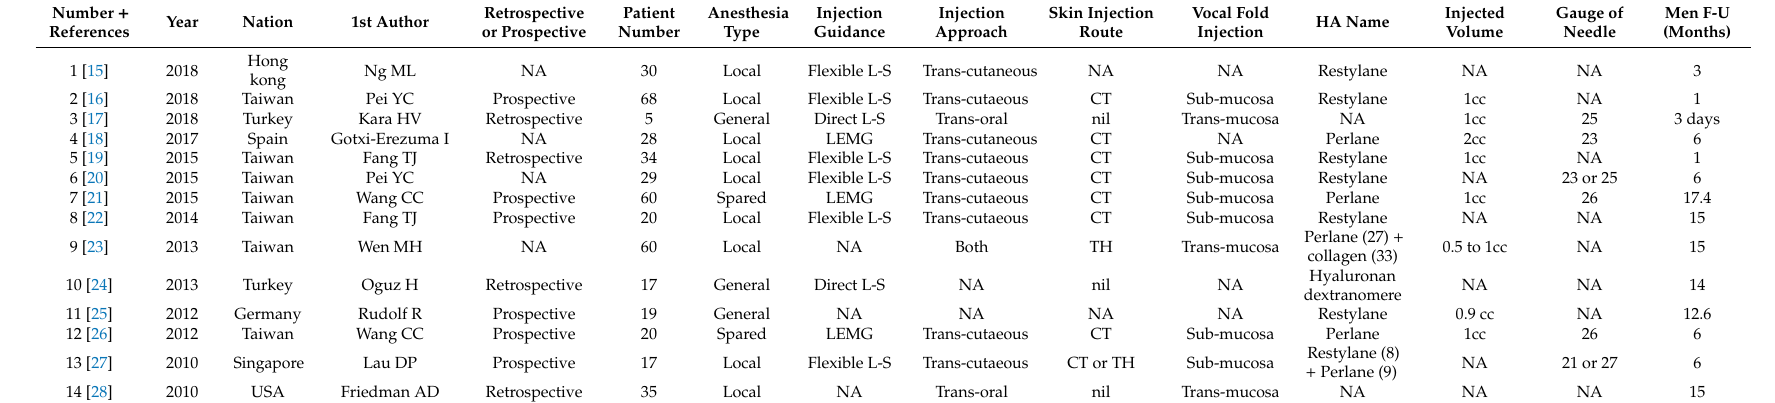
Table 2. Summary of the characteristics of reported articles discussing hyaluronic acid injection laryngoplasty for unilateral vocal fold